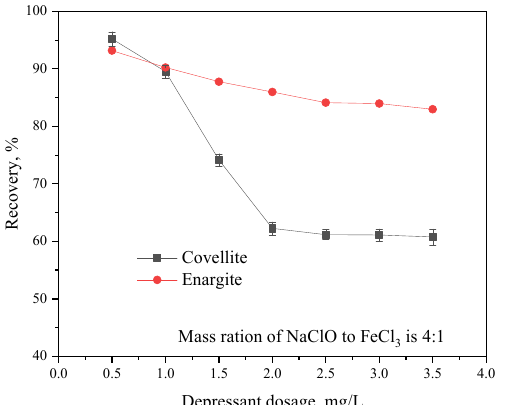
Figure 5. Effect of the depressant dosage on the flotation behavior of covellite and enargite at pH = 10.